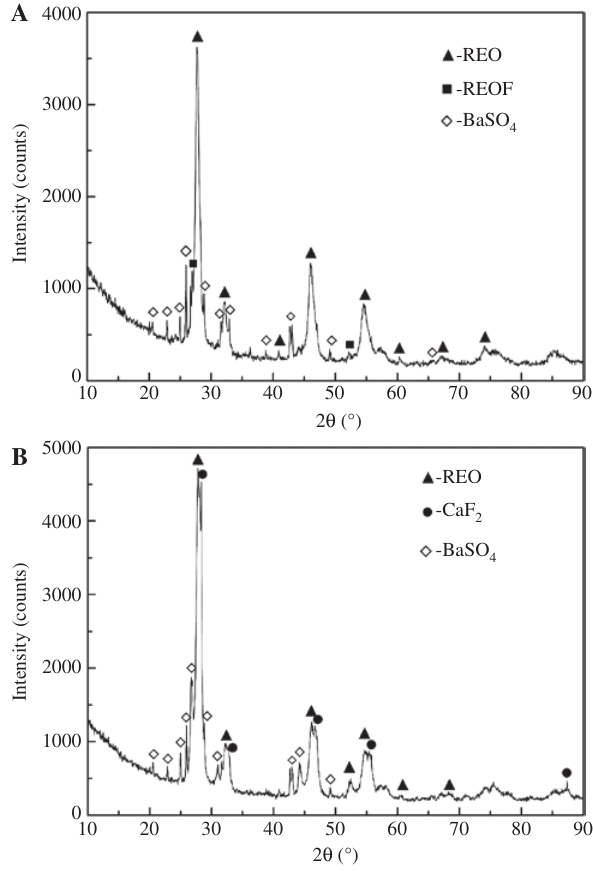
Figure 4: X-ray diffraction pattern of S2 roasted at 650 ° C and 750 ° C.